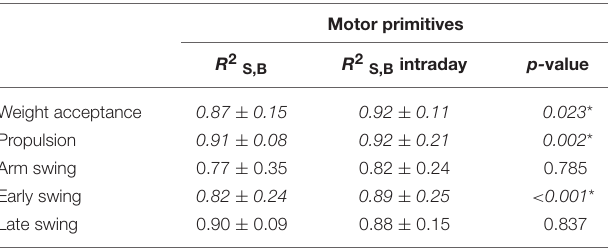
TABLE 2 | Similarities, indicated as R 2 S,B , between the motor primitives of shod and barefoot running as mean of intraday repetitions.